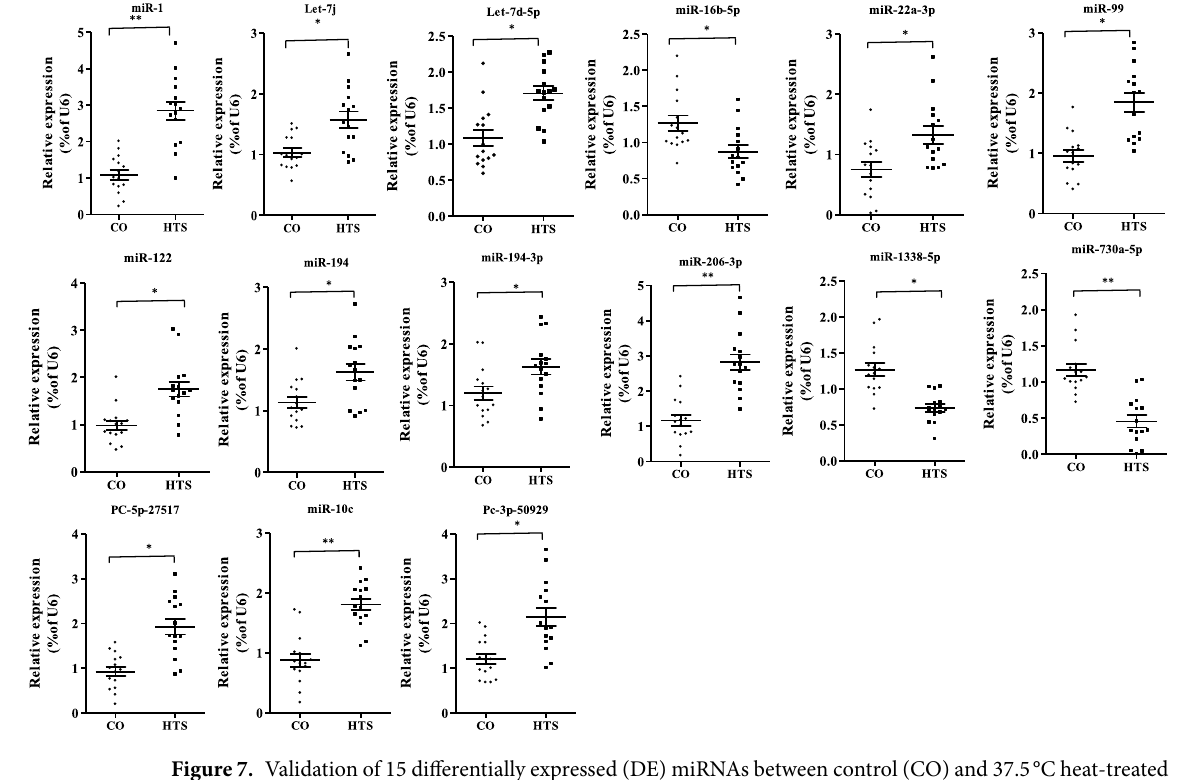
Figure 7. Validation of 15 differentially expressed (DE) miRNAs between control (CO) and 37.5 °C heat-treated (HTS) groups by qRT-PCR (n = 15 replicates per group). The values are expressed as the relative ratio with U6 as an internal control. * P < 0.05 and ** P < 0.01, by unpaired Student’s T-tests.